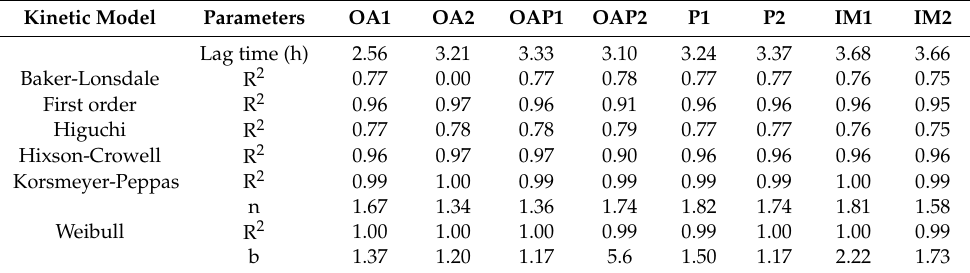
Table 3. Adjusted coefficient of determination (R 2 ) obtained by the kinetic evaluation of drug release plots and calculation of lag time. (n) The Korsmeyer-Peppas exponent of the release mechanism; (b) shape parameter of Weibull model.